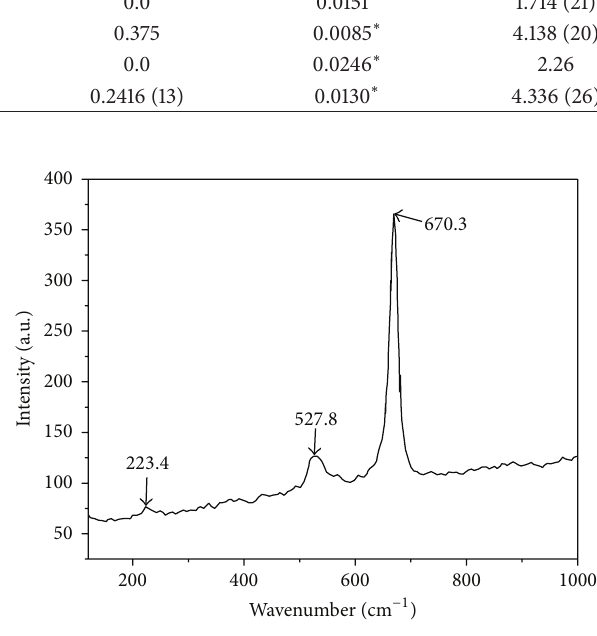
Figure 7: Raman spectrum of Cd 2 SnO 4 powder. Figure 8: Raman spectrum of Zn